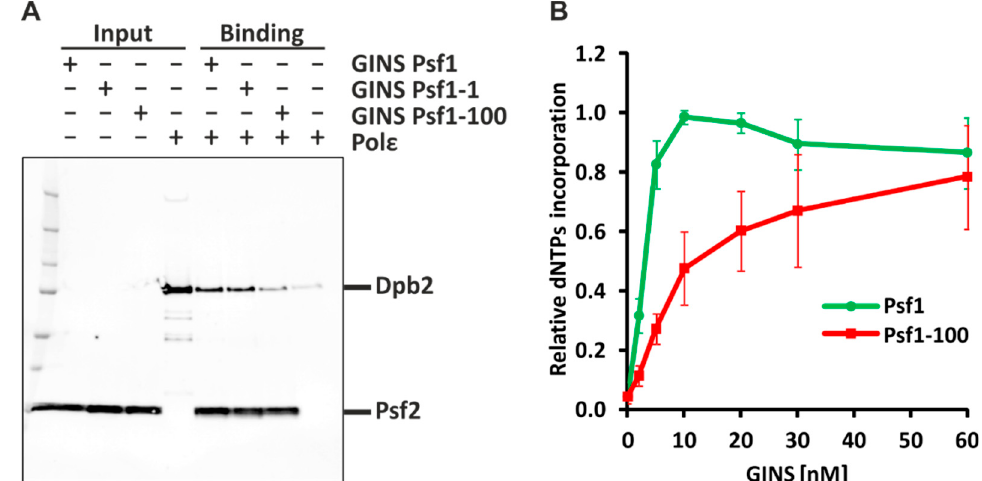
Figure 1. Psf1, Psf2, Psf3, Sld5 complex (GINS)-Pol ε in vitro interaction and DNA replication activity in the presence of GINS Psf1-100 . ( A ) Western-blot detection of Dpb2 and Psf2 subunits of Pol ε and GINS in protein mixtures separated by sodium dodecyl sulfate polyacrylamide gel electrophoresis (SDS-PAGE). Two pmol of various GINS complexes (WT, Psf1-1 and Psf1-100) containing Halotag-Sld5 were fixed on 10 µL of HaloLink Resin and then incubated with 2 pmol of Pol ε in 400 µL buffer at 30 °C for 30 min. Input of GINS and Pol ε were 0.5 and 0.05 pmol, respectively. Precision Plus Protein™ All Blue Prestained Protein Standard was used as molecular weight marker. Gel patterns of GINS and Pol ε proteins used are shown in Figure S1. ( B ) Reactions performed with increasing amounts of GINS Psf1 or GINS Psf1-100 were separated on an alkaline agarose gel, and transferred onto a membrane, before the detection of incorporated biotin-UTP using IR dye-labeled streptavidin. The signal